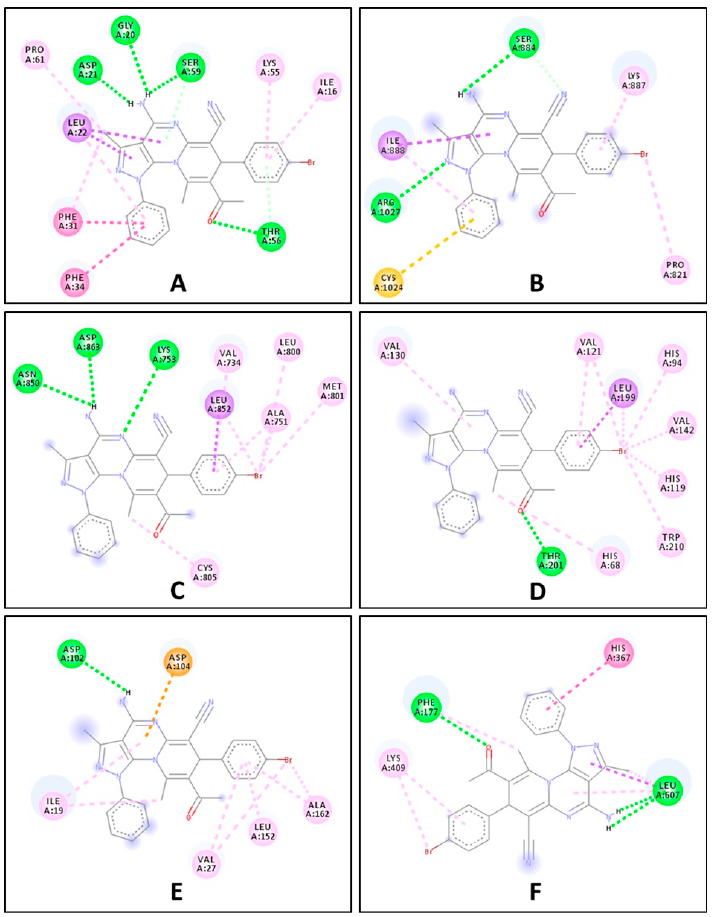
Figure 6. Docking pose (2D binding model) of the most active cytotoxic agent, 7e , in the active site of DHFR (PDB: 5HQY) ( A ), VEGFR2 (PDB: 5EW3) ( B ), HER-2 (PDB: 3RCD) ( C ), hCA-IX (PDB: 5FL4) ( D ), CDK6 (PDB: 3NUP) ( E ) and LOX5 (PDB: 3V99) ( F ).